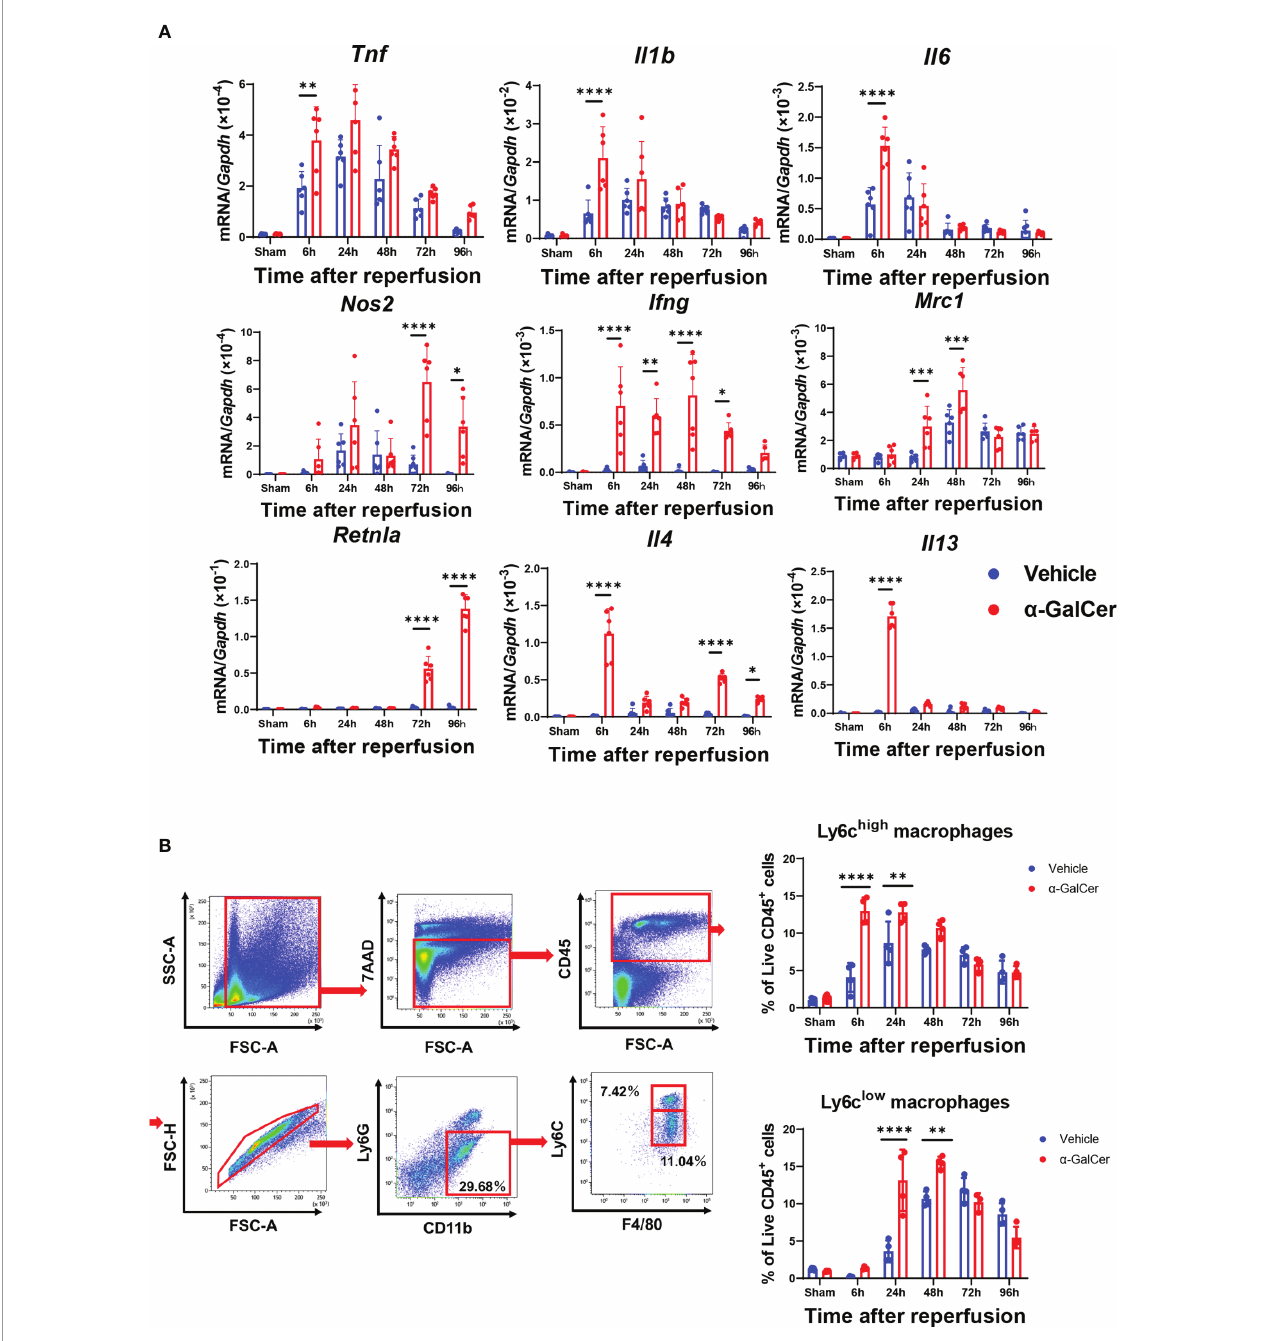
FIGURE 2 | Changes in expression of genes related to pro-in fl ammatory and reparative macrophage phenotypes and in in fi ltration of macrophages during hepatic I/R injury. (A) Expression of mRNA encoding genes related to a pro-in fl ammatory macrophage phenotype ( Tnf , Il1b, Il6, Nos2 , and Ifng ) and genes related to a reparative macrophage phenotype ( Mrc1, Retnla, Il4 , and Il13 ) in mice treated with a -GalCer or vehicle. Data are expressed as the mean ± SD (six biological replicates per group). * P < 0.05, ** P < 0.01, *** P < 0.001, **** P < 0.0001. (B) Flow cytometry gating strategy used to identify liver macrophages in mice treated with a -GalCer at 48 h post-reperfusion. After gating out Ly6G + and CD11b + cells, cells were separated into these two subsets based on expression of Ly6C and F4/80. Ly6G - /Ly6C high /CD11b high /F4/80 high cells are de fi ned as Ly6C high macrophages (pro-in fl ammatory macrophages) and Ly6G - /Ly6C low /CD11b high /F4/80 high cells are de fi ned as Ly6C low macrophages (reparative macrophages). Changes in the percentage of Ly6C high macrophages (Ly6G - /Ly6C high /CD11b high /F4/80 high cells) and Ly6C low macrophages (Ly6G - /Ly6C low /CD11b high /F4/80 high ) in livers from mice treated with a -GalCer or vehicle after hepatic I/R injury. Data are expressed as the mean ± SD (four biological replicates per group). ** P < 0.01, **** P <